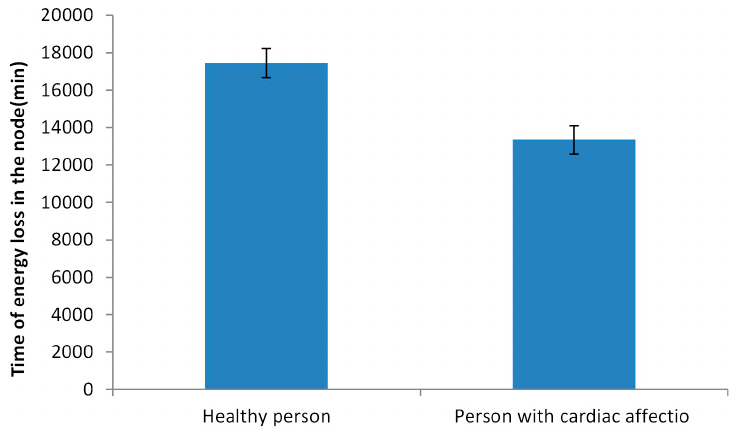
Figure 11. Lifetime of the available energy for data transmission.